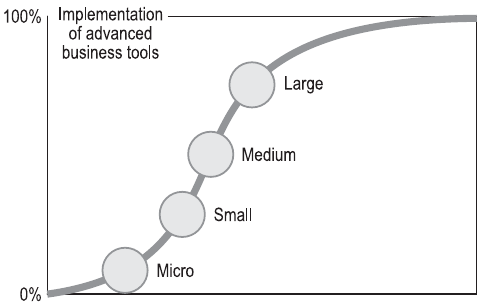
Fig. 8. Small networked partner needs particular support